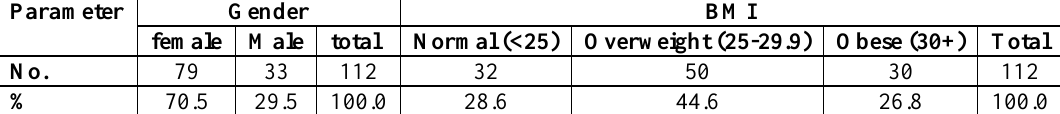
Table 1: Distribution of the dentists according to gender and body mass index. Parameter